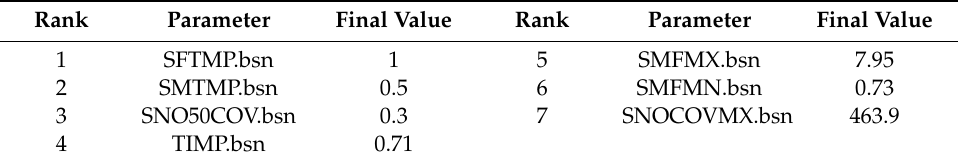
Table 1. Ranks of the most sensitive l parameters of the basin with their final calibrated values. Rank Parameter Final Value Rank Parameter Final Value